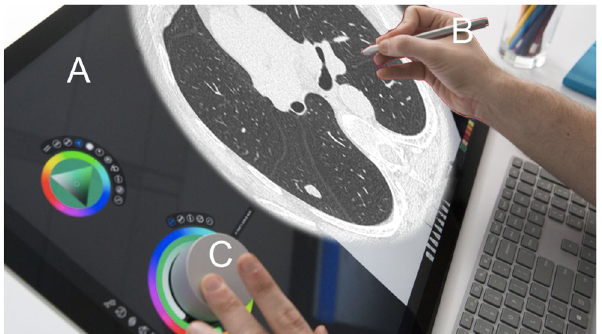
Fig. 6 Potential use of Surface Studio ® (Microsoft, Redmond, WA, USA). The screen is tactile ( a ). The stylet would be handy for direct measurement and annotation of the image ( b ). The wheel could be used to select functions such as Windows and for scrolling of images ( c ).